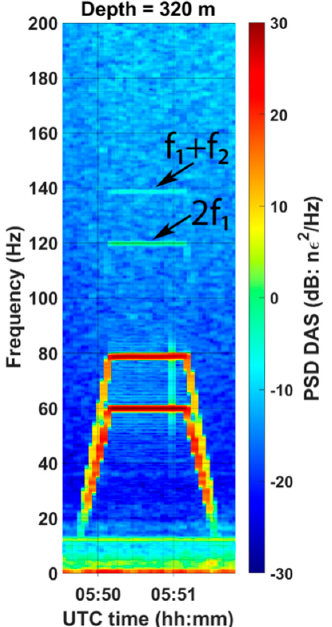
Figure 7. Spectrogram of the signal recorded 320 m deep in the well during the warmup sequence of the SOV by DAS.